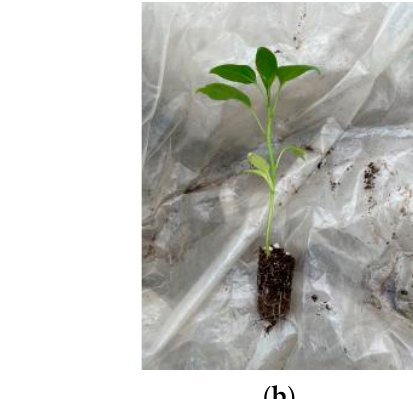
Figure 6. Pepper pot seedlings for material tests.